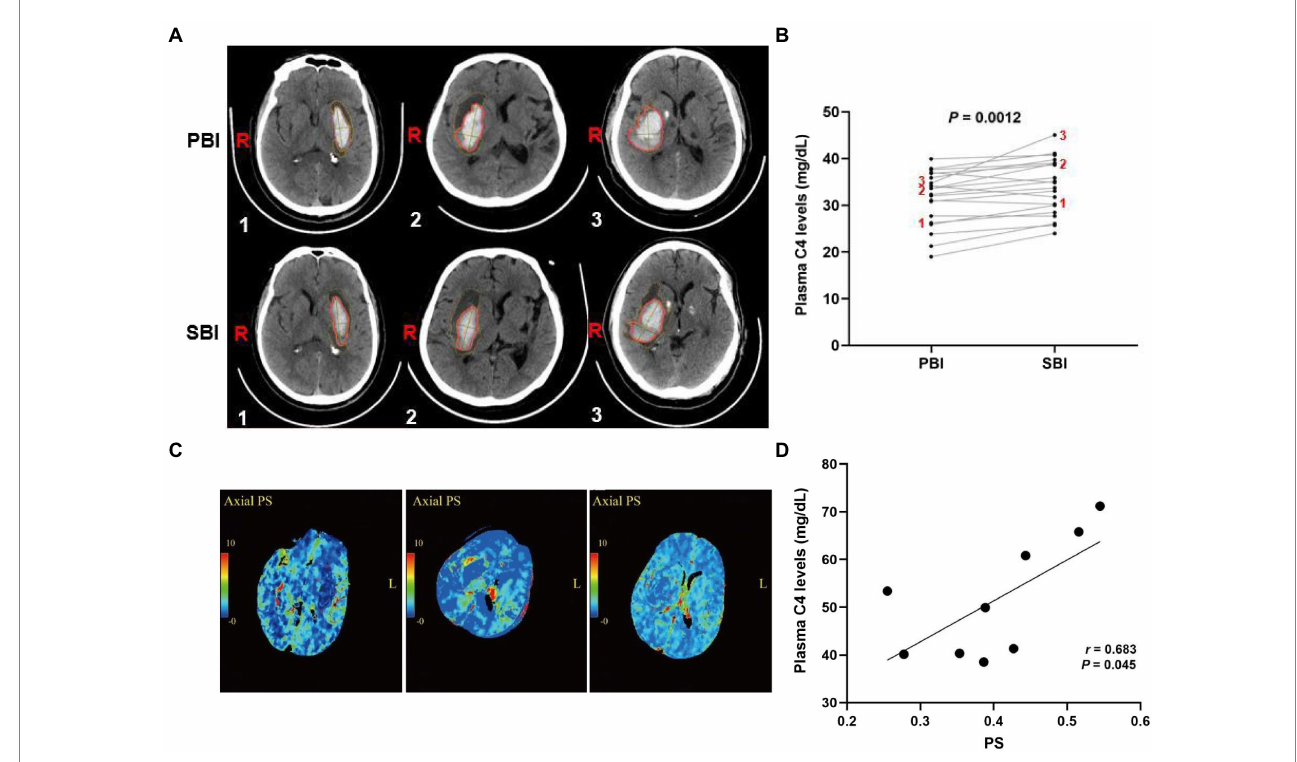
FIGURE 4 Elevated plasma complement C4 levels contribute to secondary brain injury after ICH. (A) CT images of the ICH patients in PBI and SBI and (B) plasma complement C4 levels in PBI and SBI using paired t -test (n = 20), (C) Representation of PS values at 24 h in patients with severe SBI, and (D) correlation between PS value and C4 levels at 24 h in patients with severe SBI. ICH, intracerebral hemorrhage; PBI, primary brain injury; SBI, secondary brain injury, PS, permeability